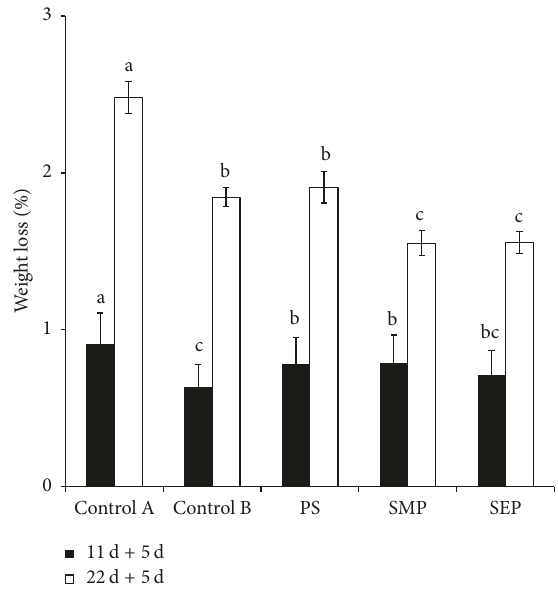
Figure 1: Weight loss of “Friar” plums uncoated or coated with hydroxypropyl methylcellulose-beeswax edible coatings containing potassium sorbate (PS), sodium methyl paraben (SMP), or sodium ethyl paraben (SEP) and stored for 11 and 22 d at 1 ∘ C followed by 5 d at 20 ∘ C. Control A: uncoated; Control B: coating without antifungal agent. For each storage time, bars with different letters are significantly different according to Duncan’s range test ( 𝑃 < 0.05 ) ( 𝑛 = 20